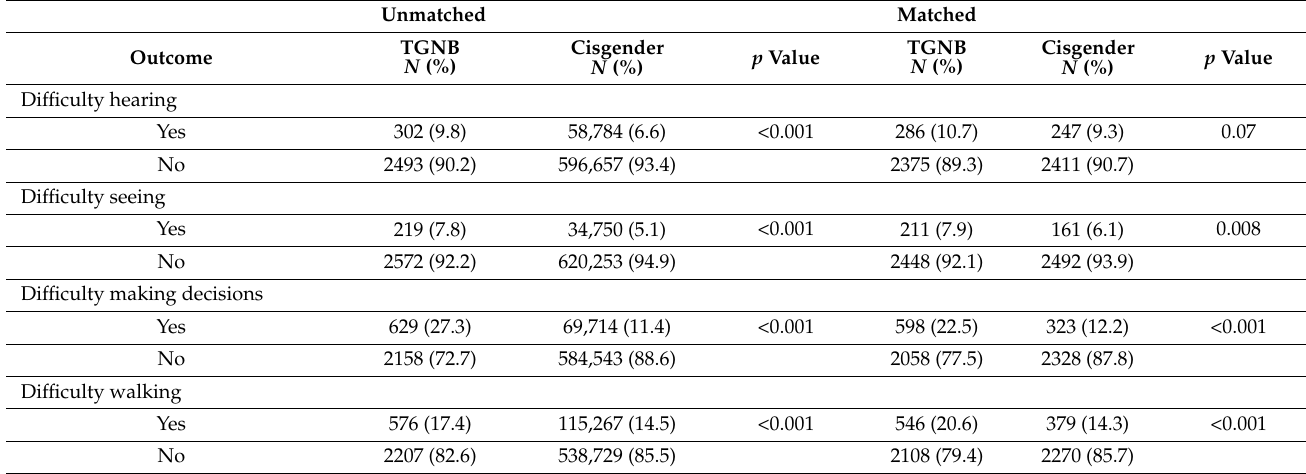
Table 4. Burden of physical and mental disabilities among unmatched and matched samples. Unmatched